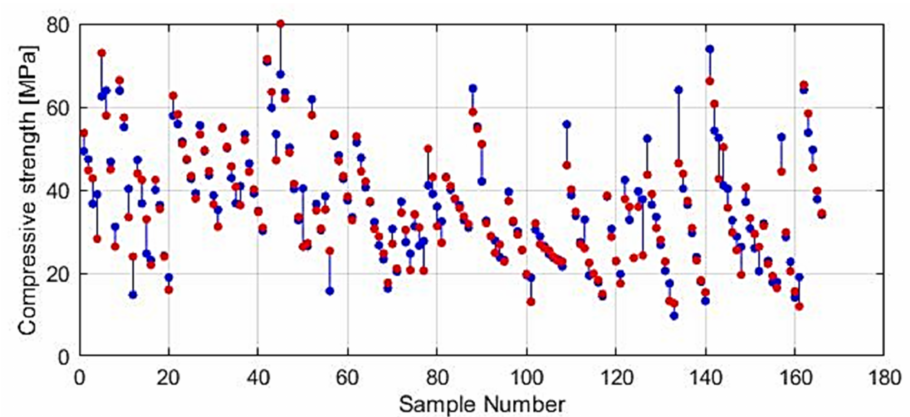
Figure 18. Modelled and target values for reduced GPR ARD Matern 3/2 model.